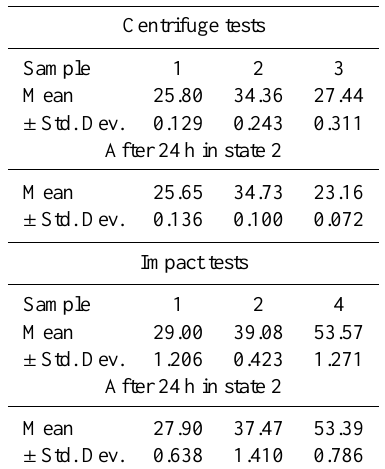
Table 5. Sample means and standard deviations for all 14 ◦ config- uration tests, reported in g’s.